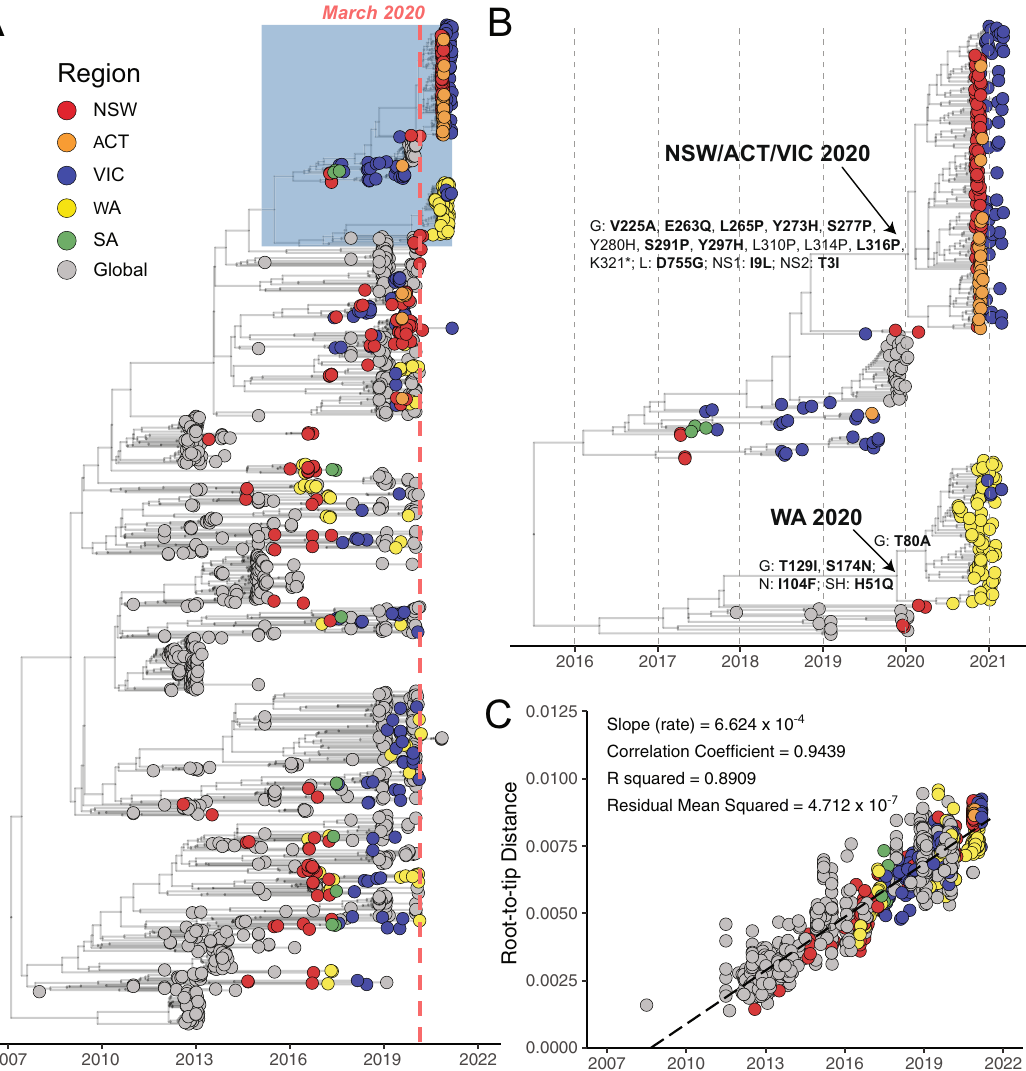
Fig. 2 Phylogenetic analysis of global and Australian RSV-A genome sequences. A RSV-A genome sequences were aligned with NCBI GenBank reference sequences and analysed using a Bayesian molecular clock approach estimated with BEAST (v1.10) focused on recent ON1-like viruses. Australian states — New South Wales (NSW), Australia Capital Territory (ACT), Western Australia (WA) and Victoria (VIC), and South Australia (SA) — and globally- derived sequences are coloured according to the key provided. The light red dotted line marks March 2020 and the beginning of extensive COVID-19- related restrictions. The blue shaded box is expanded in panel ( B ), which is a focused analysis of NSW/ACT/VIC and WA 2020 lineages. Amino acid mutations inferred by TreeTime are labelled on select branches, and those under signi fi cant selection pressure are shown in bold. C Temporal signal in RSV-A genomic dataset determined by linear-regression of root-to-tip distance ( y -axis) against sample collection date ( x